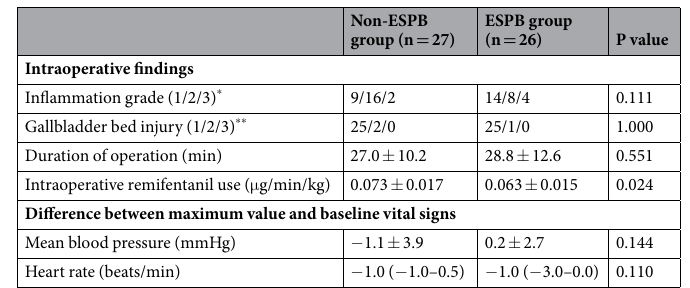
Table 2. Intraoperative data. Data presented as n (%) the mean( ± SD) or median (interquartile range) for continuous variables, or absolute number for categorical variables, as appropriate. * Evaluated by Parkland grading method. ** Evaluated by operating surgeon as follows: 1. Insignificant injury to liver, 2. Mild injury to liver 3. Moderate injury to